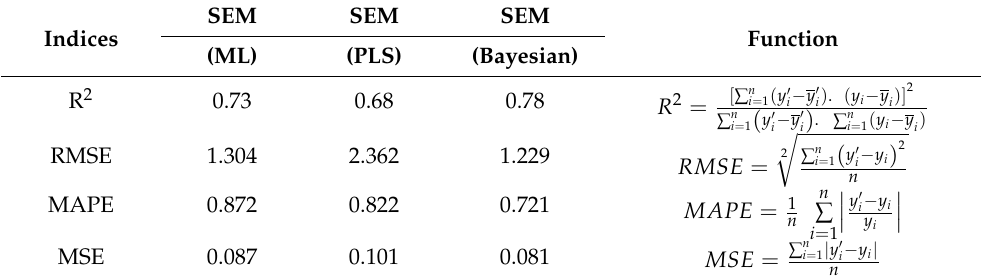
Table 4. Comparative among of SEM-ML, SEM-PLS, and SEM-Bayesian outputs.